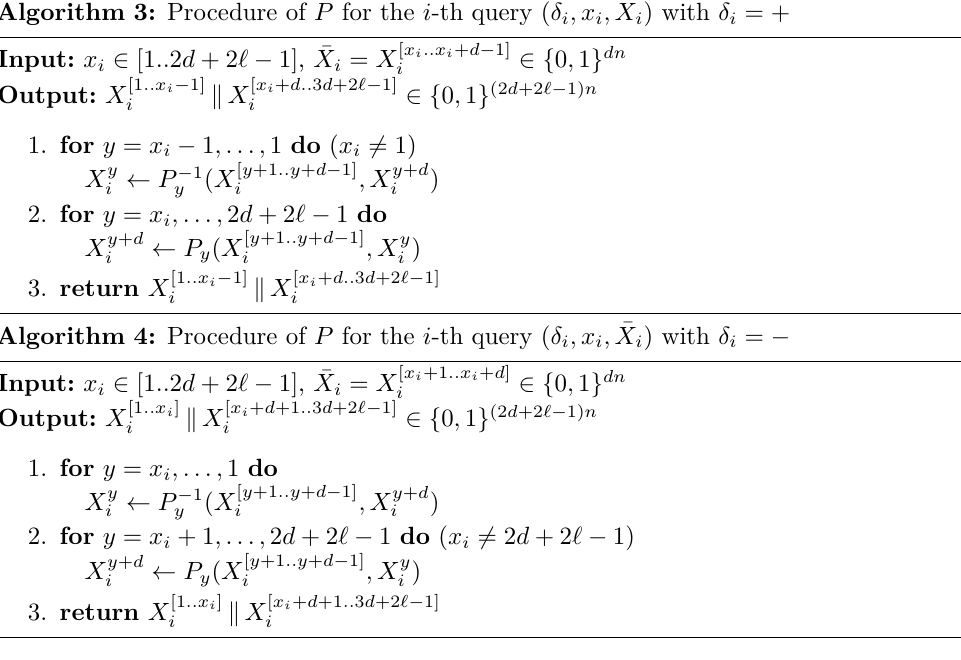
1 , . . . , P − 1 and x i 1 1 − δ i = is analogously −